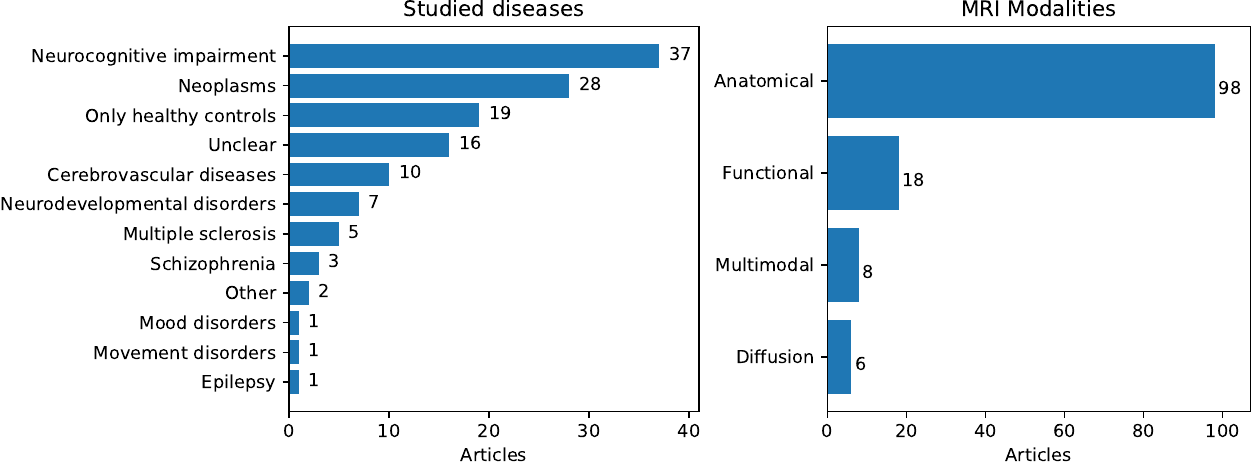
Figure 2. ( Left ): Number of articles according to the ICD-11 category. ( Right ): Number of articles per MRI